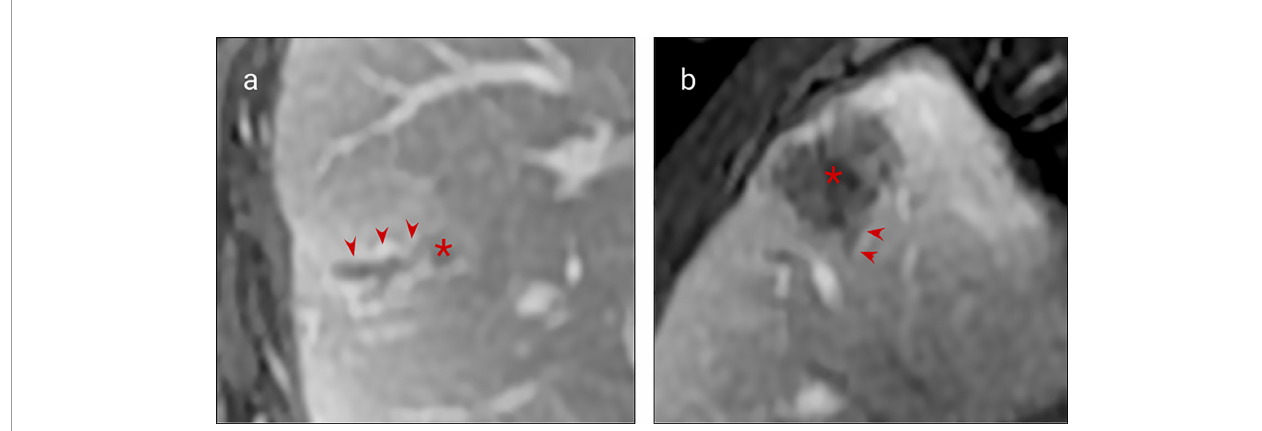
FIGURE 2 | MRI examples of histologically con fi rmed CRLM with macroscopic vascular invasion. (A, B) Portal venous phase gadolinium-enhanced T1 fat saturated MRI shows CRLM lesions (asterisk) with a fi lling defect within a hepatic vein indicating macroscopic venous invasion